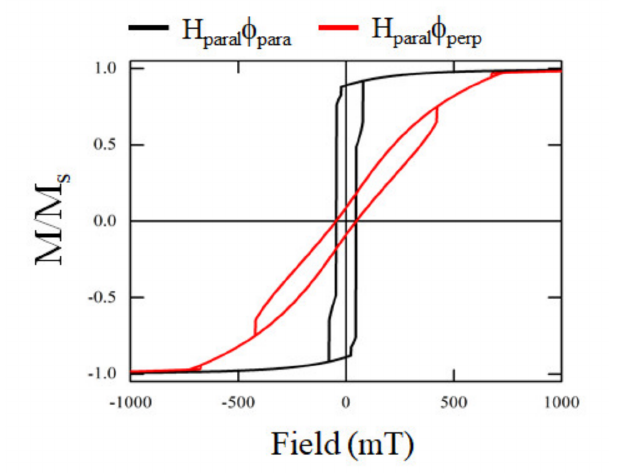
Figure A1. Hysteresis loops for an isolated conical nanostructure with D 1 = 30 nm, D 2 = 52.5 nm, and h = 55 nm in the absence of magnetocrystalline anisotropy when a magnetic field is applied parallel ( H paral Φ paral , black line) and perpendicular ( H paral Φ perp , red line) to the y -axis of the